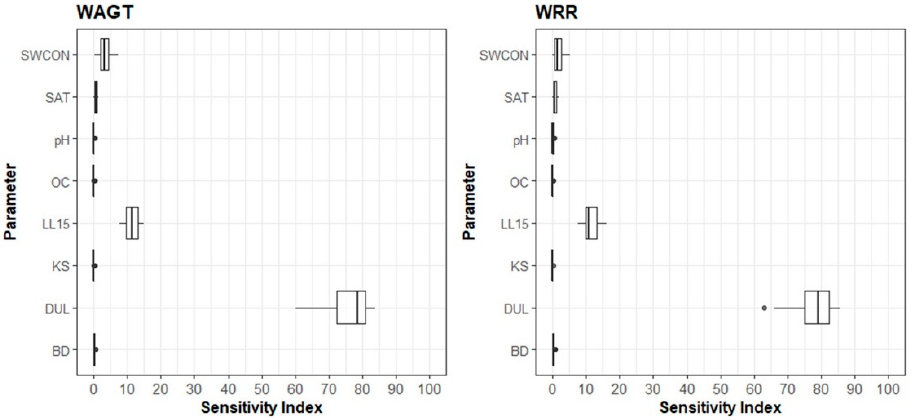
Figure 2. Variation of the the sensitivity index ( Si ) of selected soil parameters on the simulated total above-ground dry matter (WAGT) and simulated dry-weight of rough rice (WRR) for rice in Sri Lanka.